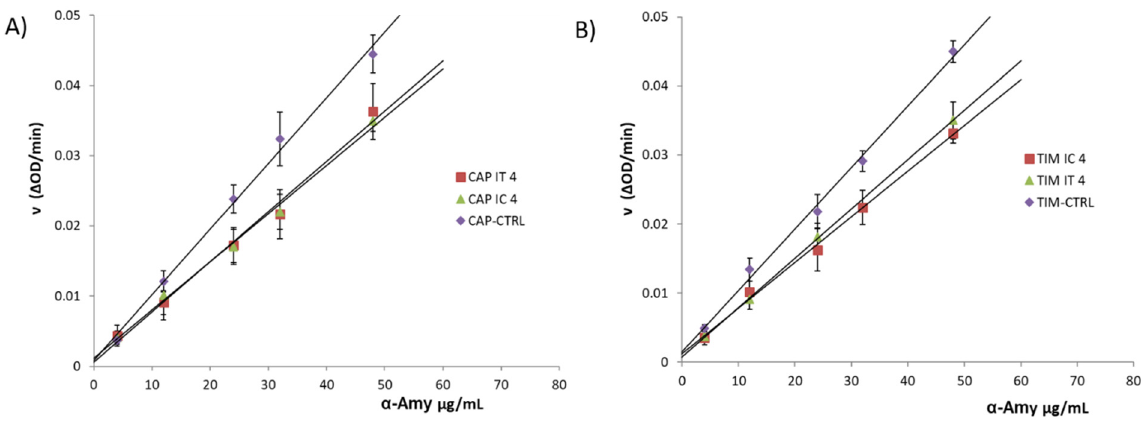
Figure 1. The reversibility effect of ( A ) CAP-CTRL and CAP-IC4 and CAP-IT4; ( B ) TM-CTRL and TIM-IC2 and TIM-IT2 on the α -Amylase activity.